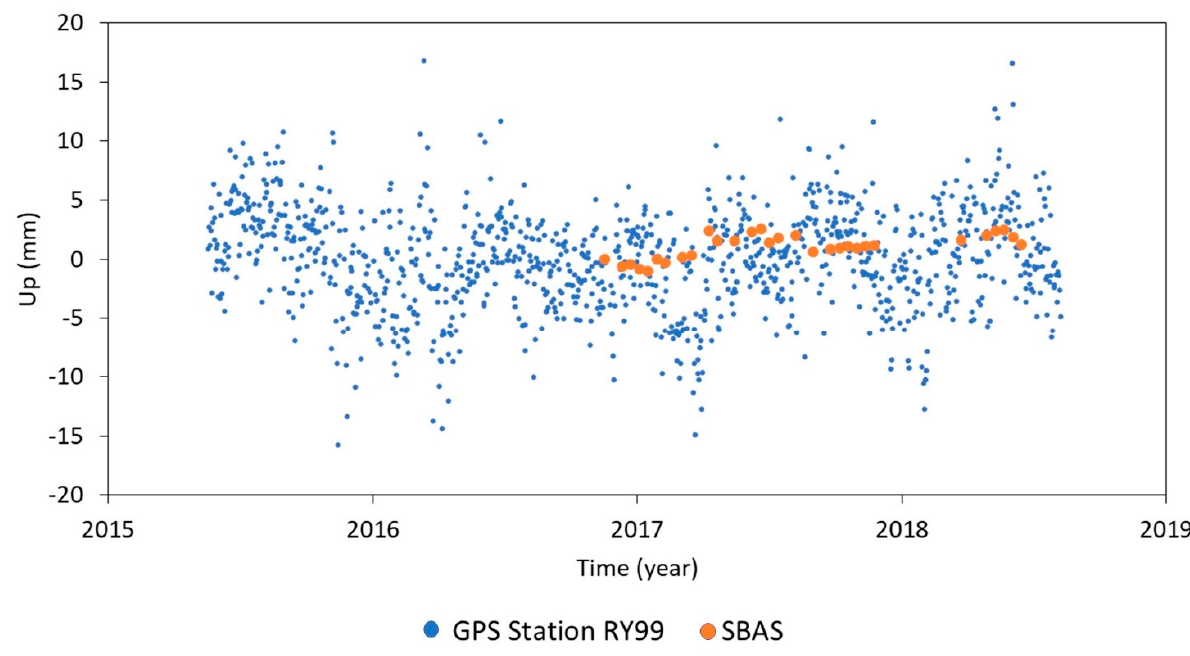
Figure 6. Comparison of vertical GPS velocities from the permanent Riyadh GPS station (projected to satellite LOS direction) to the LOS SBAS velocities over the station.